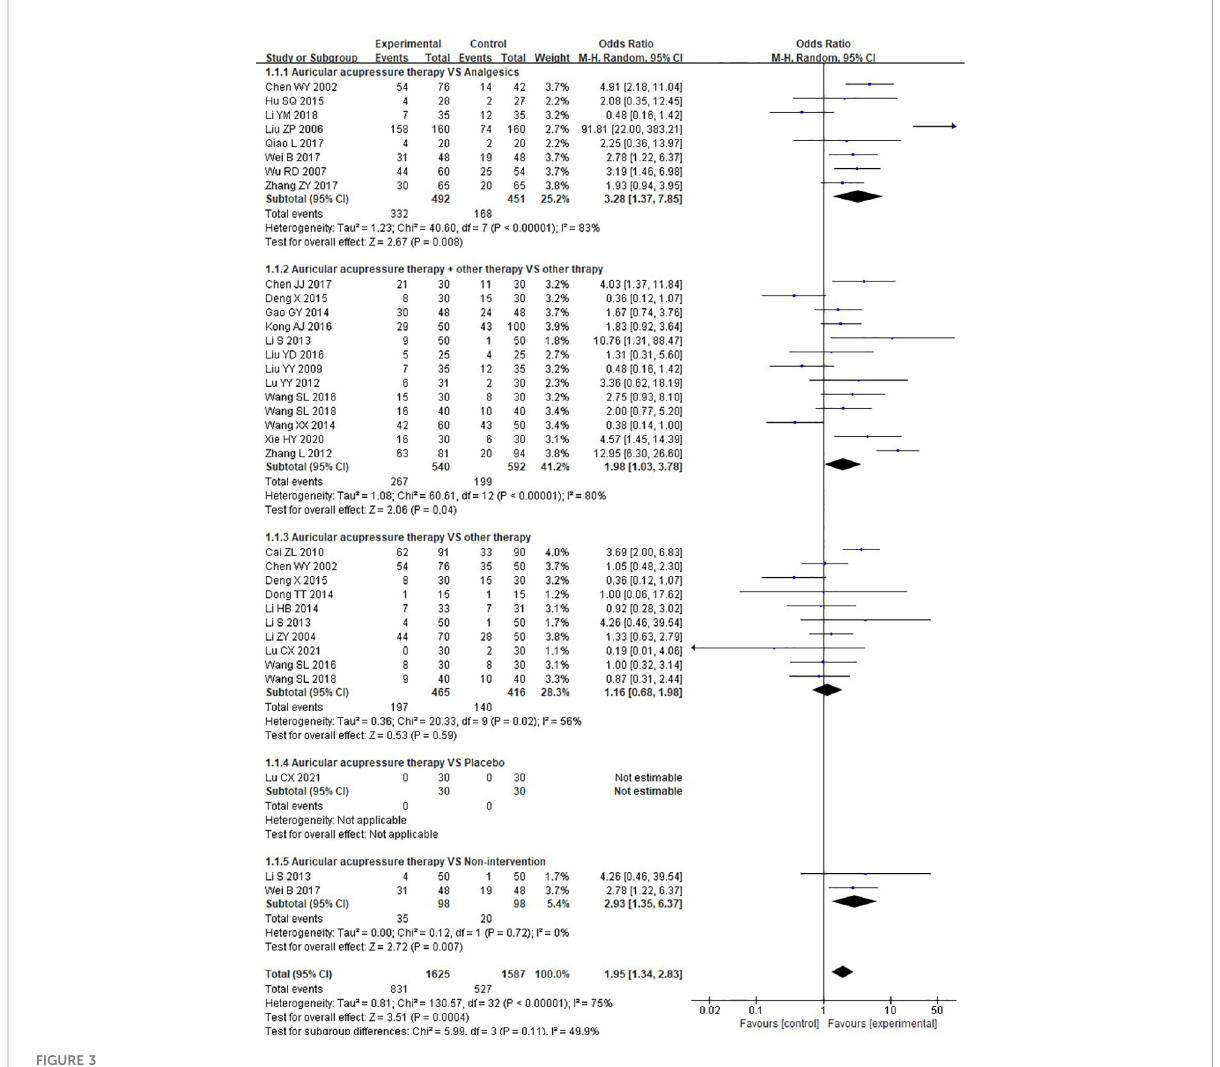
FIGURE 3 Meta-analysis and forest plot for cured